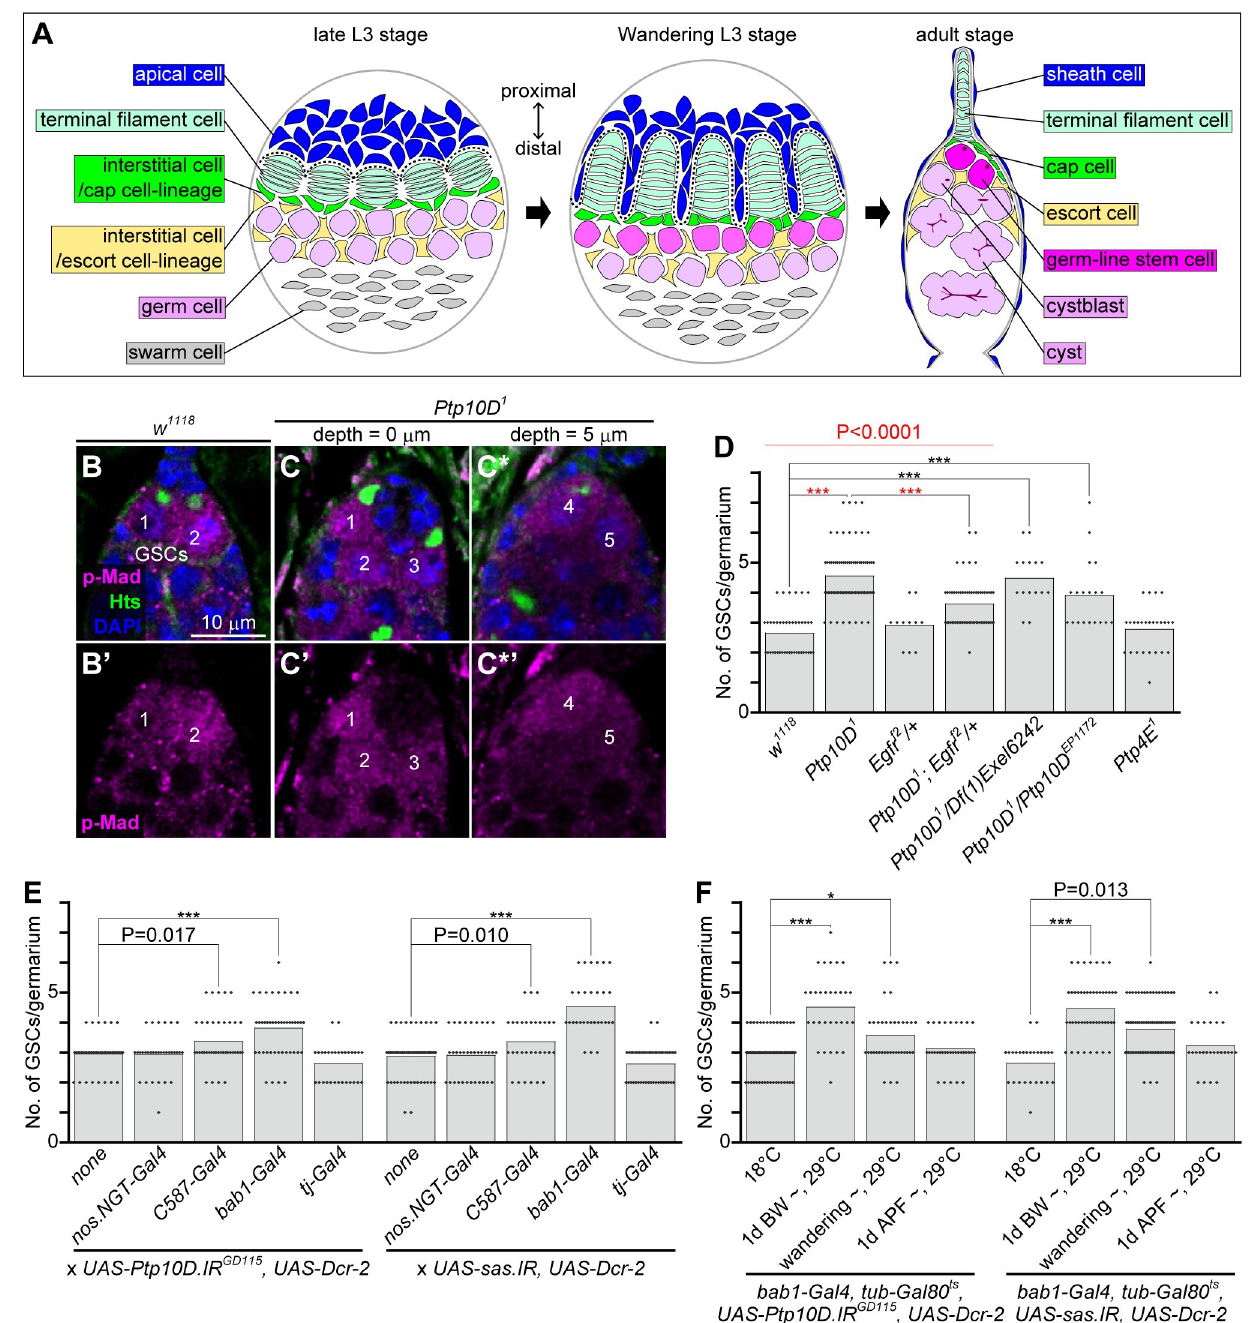
Fig 1. Loss of Ptp10D or sas in gonadal apical cells causes excessive number of ovarian GSCs. (A) A schematic diagram depicts the female gonadogenesis. Cell types constituting gonad are drawn by pseudo-colors as apical cells, terminal filament cells, cap cells/sheathe cells (interstitial cells), escort cells (interstitial cells), germ cells/germ-line stem cells/cystblasts/cysts, and swarm cells are colored with blue, pale green, green, light yellow, pink, and gray, respectively. Corresponding cell-types in larval and adult stages are drawn by same colors. (B and C) Proximal regions of female germaria 1 day after eclosion without mating labeled with anti-p-Mad antibody (magenta), anti-Hts antibody (green), and DAPI (blue). Proximal is to the top. w 1118 (B) and Ptp10D 1 homozygotes (C) with two and five GSCs, respectively, are shown as examples. Numberings on (B, B’, C, C’, C * and C * ’) indicate GSCs. (C * ) Another optical section of (C) for indicating the GSCs residing deeper location. (B’, C’, and C * ’) Magenta channels of (B, C, and C * ). Scale bar in (B) is 10 μ m, and applicable for (C and C * ). (D-F) Bar graphs overlaid with beeswarm plots represent numbers (No.) of GSCs per germarium. Genotypes (D), Gal4 lines driving UAS-Ptp10D . IR GD115 (lane 1–5 in E) and UAS-sas . IR (lane 6–10 in E), and temperature-shift conditions in indicated flies (F) are shown. Dcr-2 was used to enhance RNAi efficiency. Data values indicated by 18˚C in (F) are from germaria at 2 days after eclosion without mating